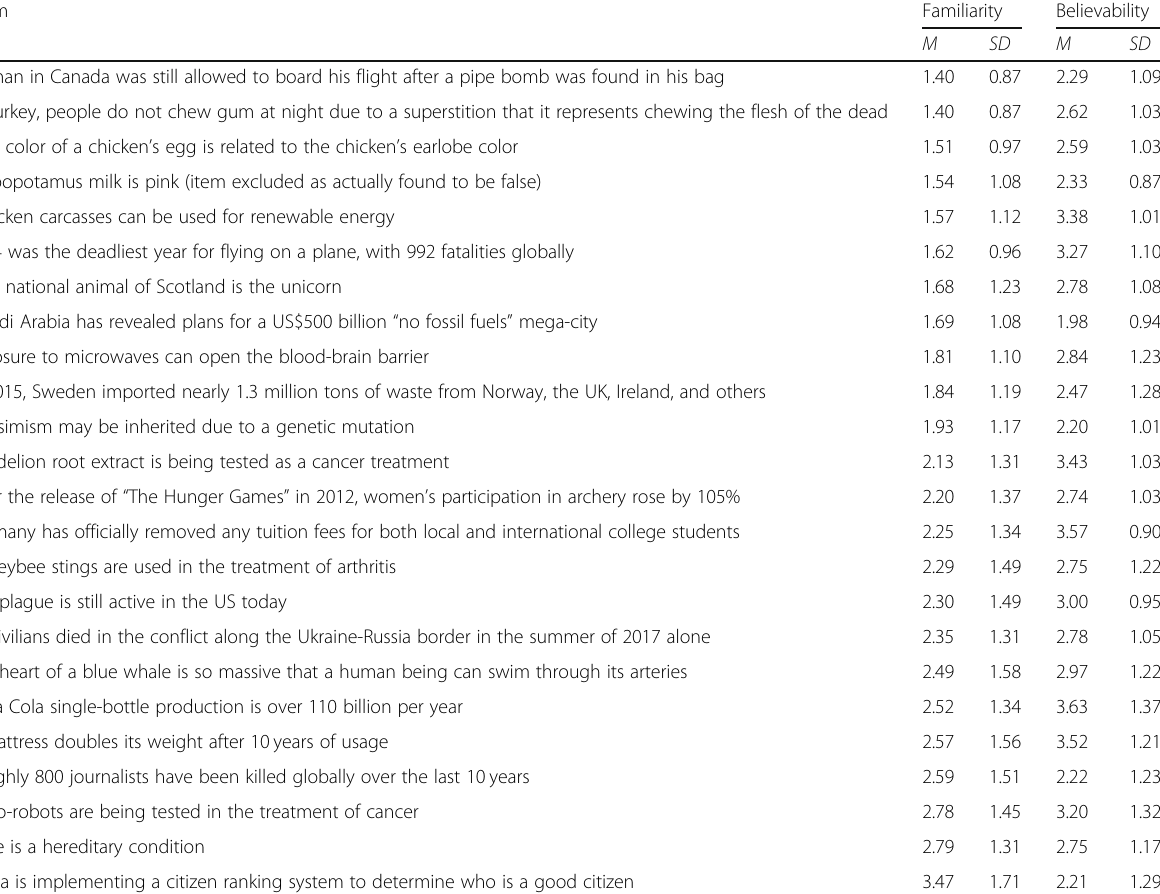
Table 6 Familiarity and believability ratings of true claims in pilot study